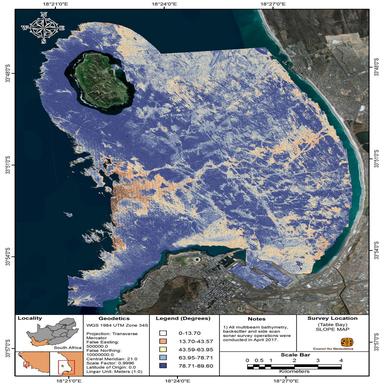
A slope map of Table Bay, in which the steepness at each cell of a raster surface is identified. The lower the slope value, the flatter the terrain; the higher the slope value, the steeper the terrain. Areas dominated by rock outcrops are steeply sloping, as expected.